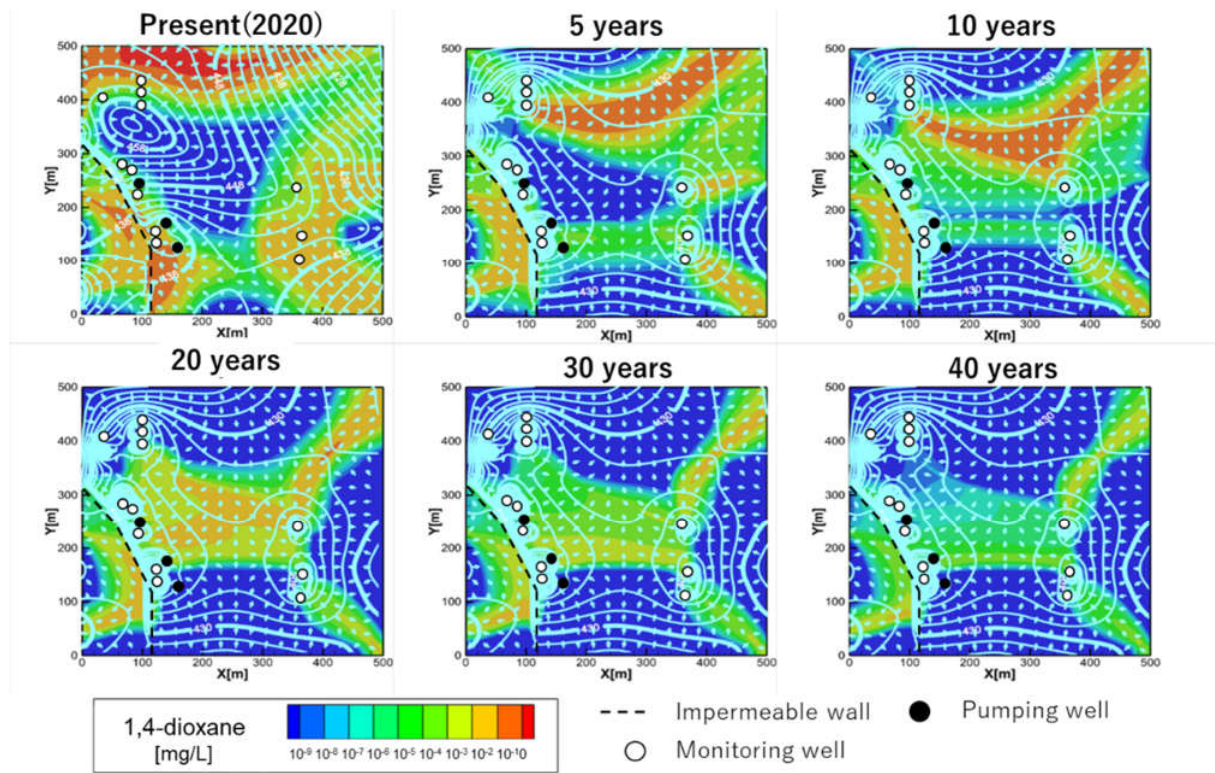
Figure 5. 1,4-Dioxane concentrations in groundwater by active treatment over time. Contour lines indicate groundwater levels and vectors indicate flow directions. The color of the legend indicates the concentration of 1,4-dioxane .